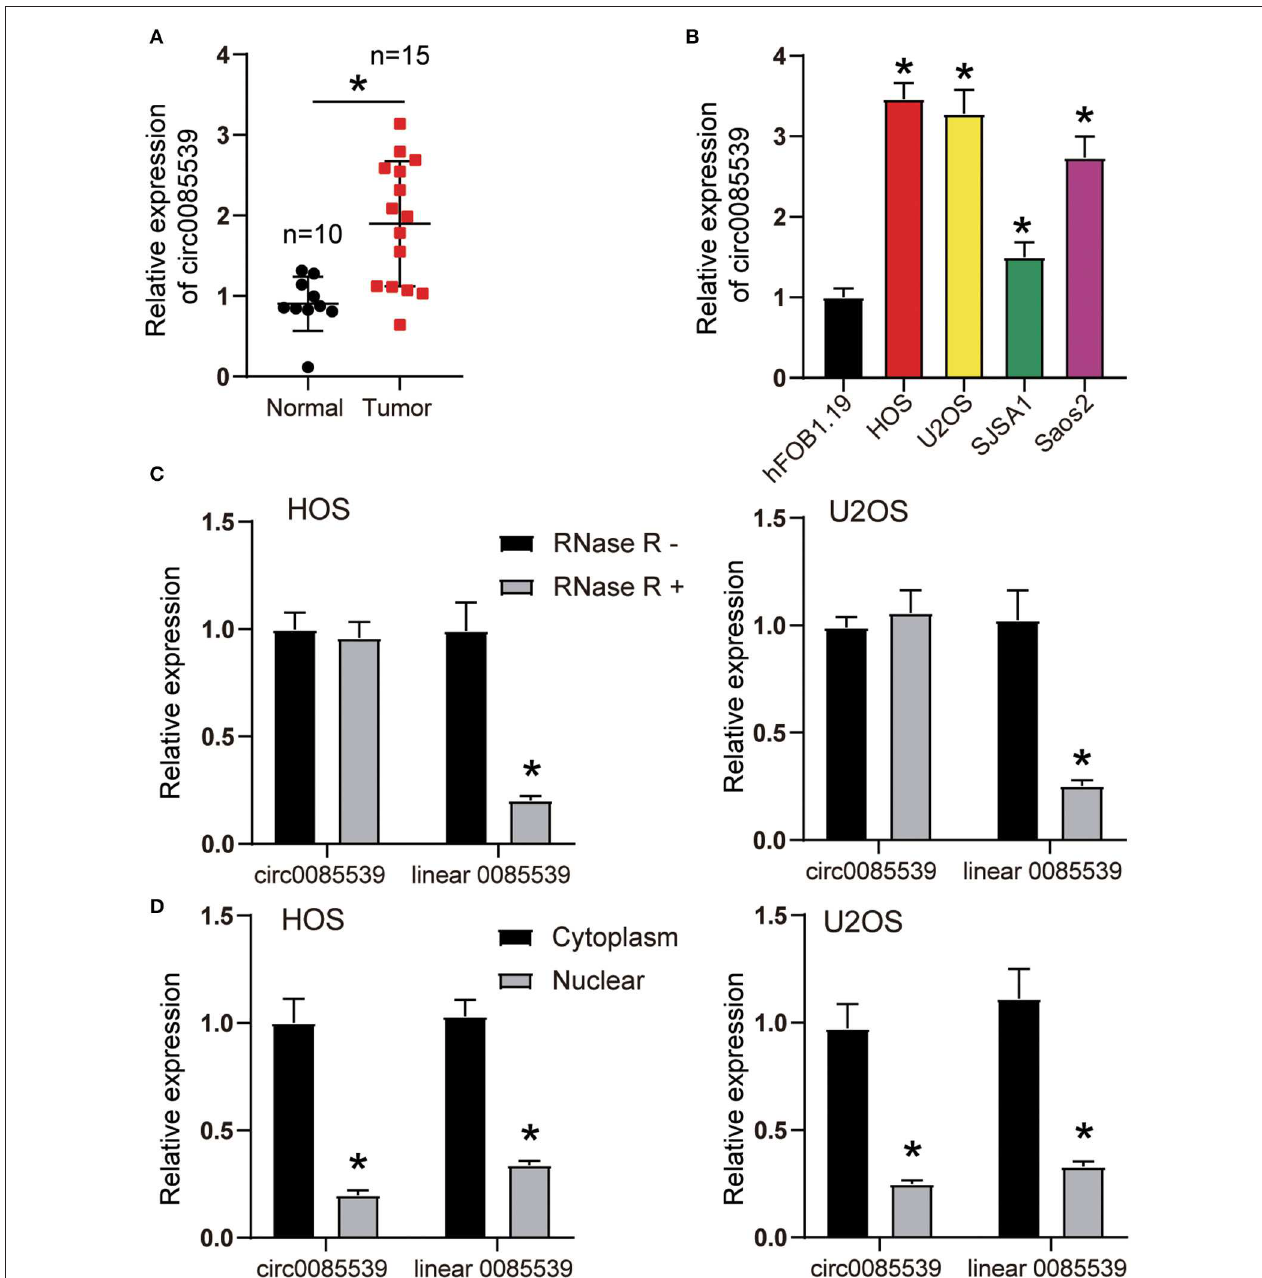
FIGURE 1 | The expression of circ0085539 in human osteosarcoma tissues and the characterization of circ0085539 in human osteosarcoma cells. (A) The relative expression of circ0085539 in 15 human osteosarcoma and 10 adjacent tissues. Normal: adjacent tissues. * p < 0.05 vs. normal group. (B) The relative expression of circ0085539 in osteosarcoma cell lines (HOS, U2OS, SJSA1, Saos2) and the normal human osteoblast cell line (hFOB1.19) were detected by quantitative reverse transcription PCR (qRT-PCR). * p < 0.05 vs. hFOB1.19 cell line. (C) The qRT-PCR analysis confirmed that linear 0085539 could be easily digested by RNase R, while circ0085539 resisted to RNase R digestion. * p < 0.05 vs. RNase R group. (D) The qRT-PCR analysis showed that circ0085539 and linear 0085539 were predominately distributed in the cytoplasm of HOS and U2OS cells. * p < 0.05 vs.